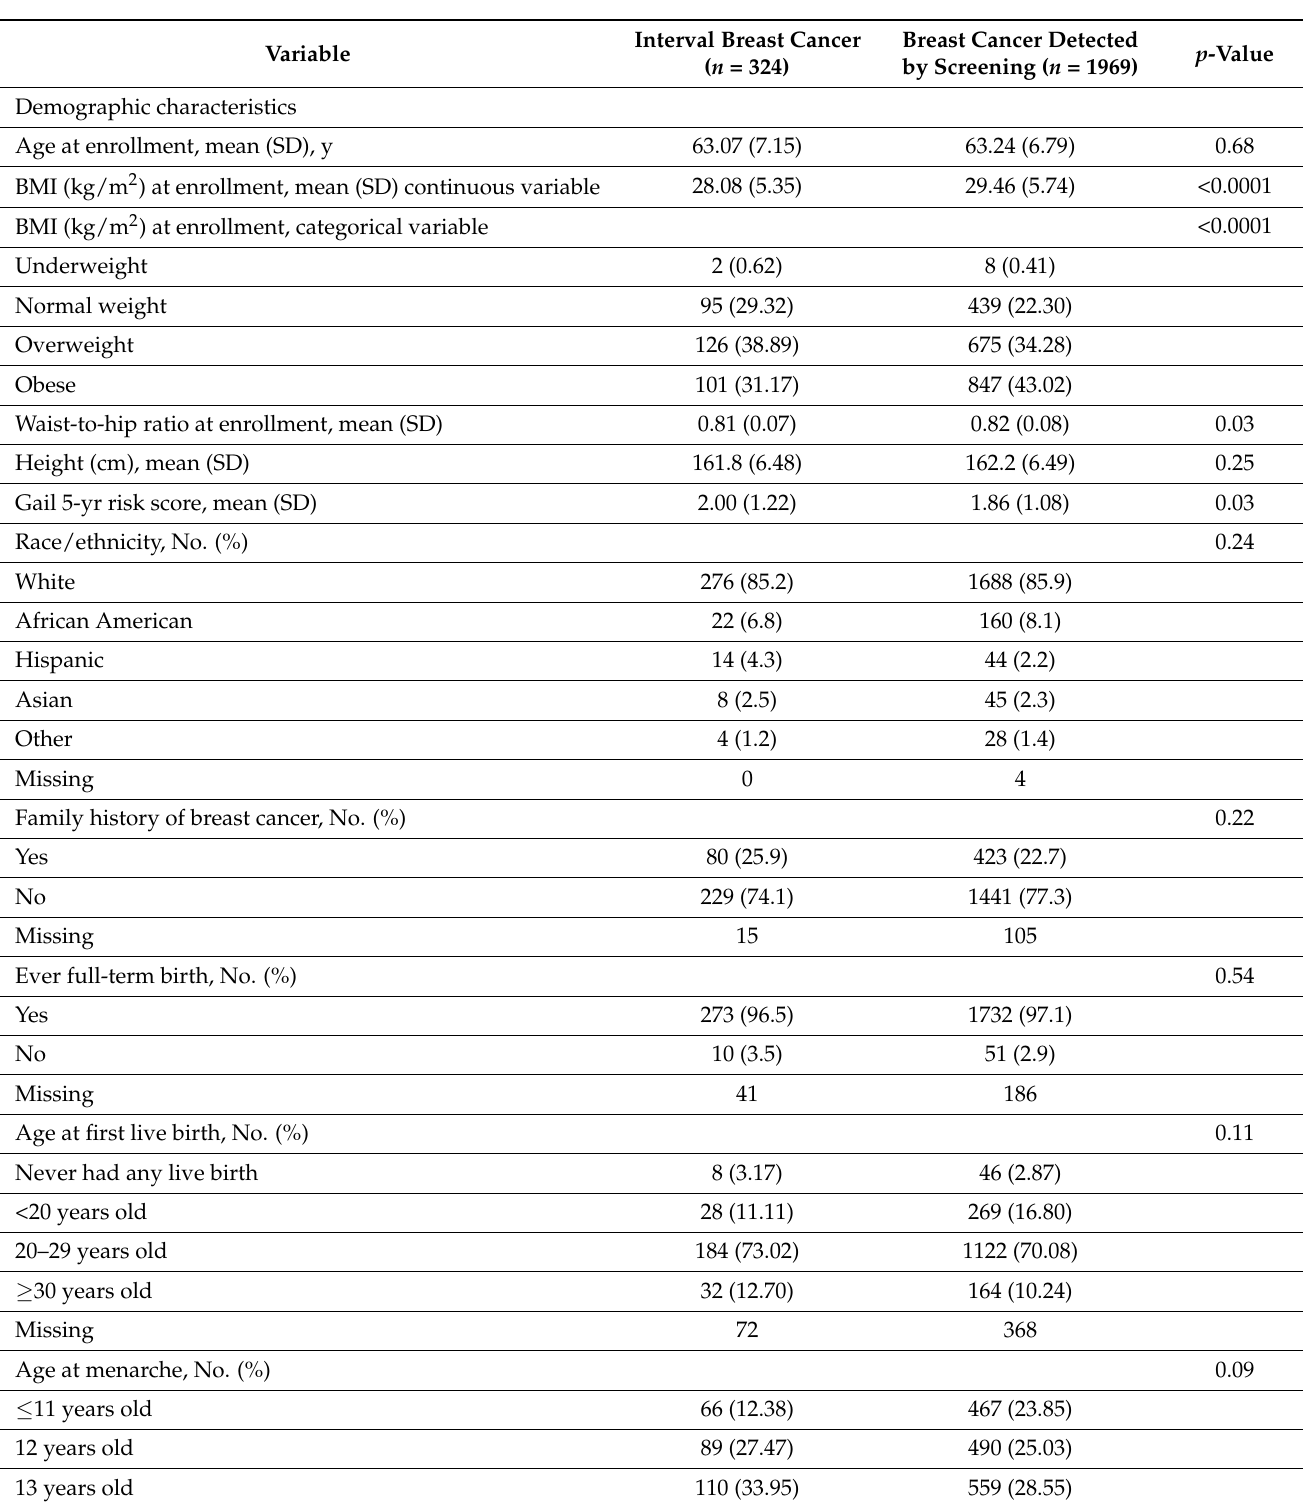
Table 1. Demographic and lifestyle characteristics of women diagnosed with interval breast cancer and screening-detected breast